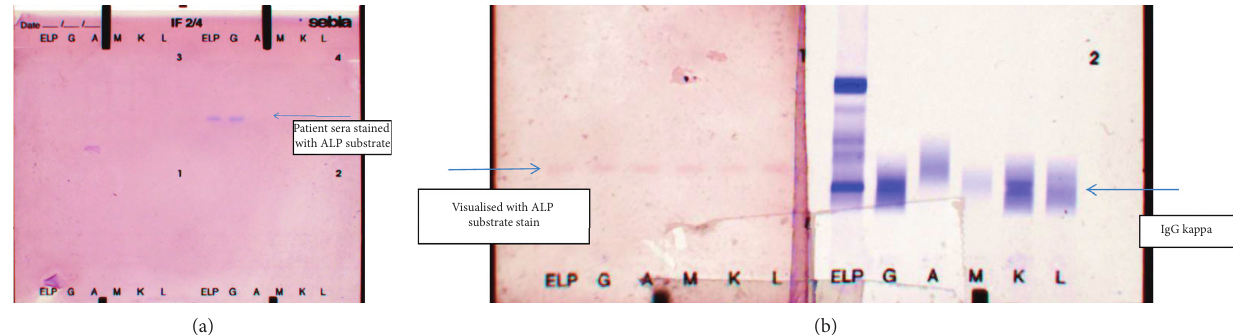
Figure 3: (a) Immunofixation gels stained with alkaline phosphatase substrate. Three control sera and the patient’s sera were electro- phoresed using the Sebia immunofixation gel and stained with ALP substrate. Gel 1–3: three control sera on all lanes. Gel 4: lanes 1 and 2: the patient’s sera. (b) Comparative stain of the immunofixation gel with alkaline phosphatase substrate and anti-IgG/A/M heavy chain and kappa/lambda light chain. Gel 1: lanes 1–6: the patient’s sera stained with alkaline phosphatase substrate. Gel 2: lanes 1–6: the patient’s sera stained with antisera to immunoglobulin heavy chain and light